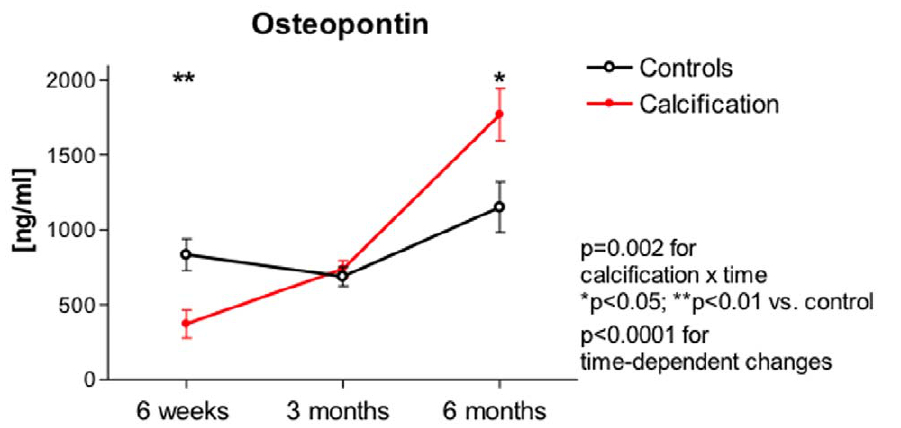
Figure 3. Urinary concentrations of OPN are shown in NC patients and control transplant patients without signs of calcification at the indicated time points. Patients with calcification are depicted in red. doi:10.1371/journal.pone.0052039.g003 changes in the early course after transplantation. (2) Only urinary biopsy specimens at the mRNA level. (4) The local protein levels of OPN are different between patients with and without expression of fetuin-A, MGP and OPN is specifically increased calcification. (3) Expression of these modulators is not different in